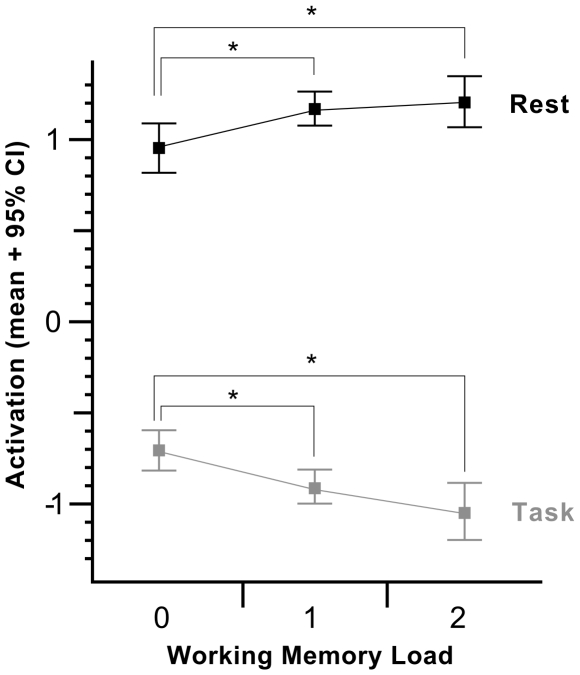
Mean of activation in the DMN.Mean of activation in the DMN were calculated for each n-back (lower values: 0-back, 1-back, 2-back) and subsequent resting block (upper values: R0-back, R1-back, R2-back). x-Axis: working memory load, y-Axis: activation as extracted by TICA for the selected component (which can differ in scaling and mean).